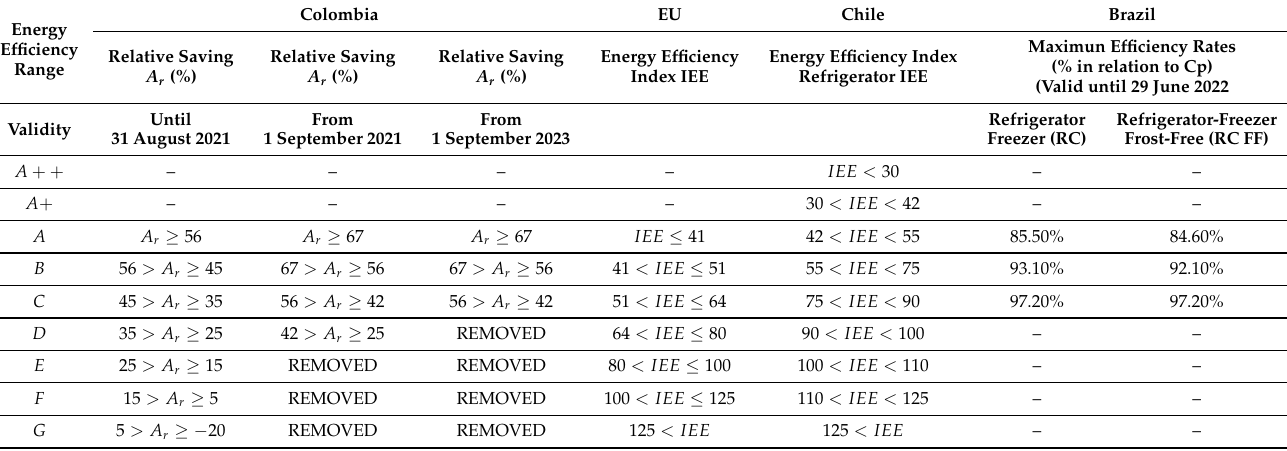
Table 9. Energy efficiency ranges for domestic refrigerators in Colombia, EU, Chile and Brazil. Energy